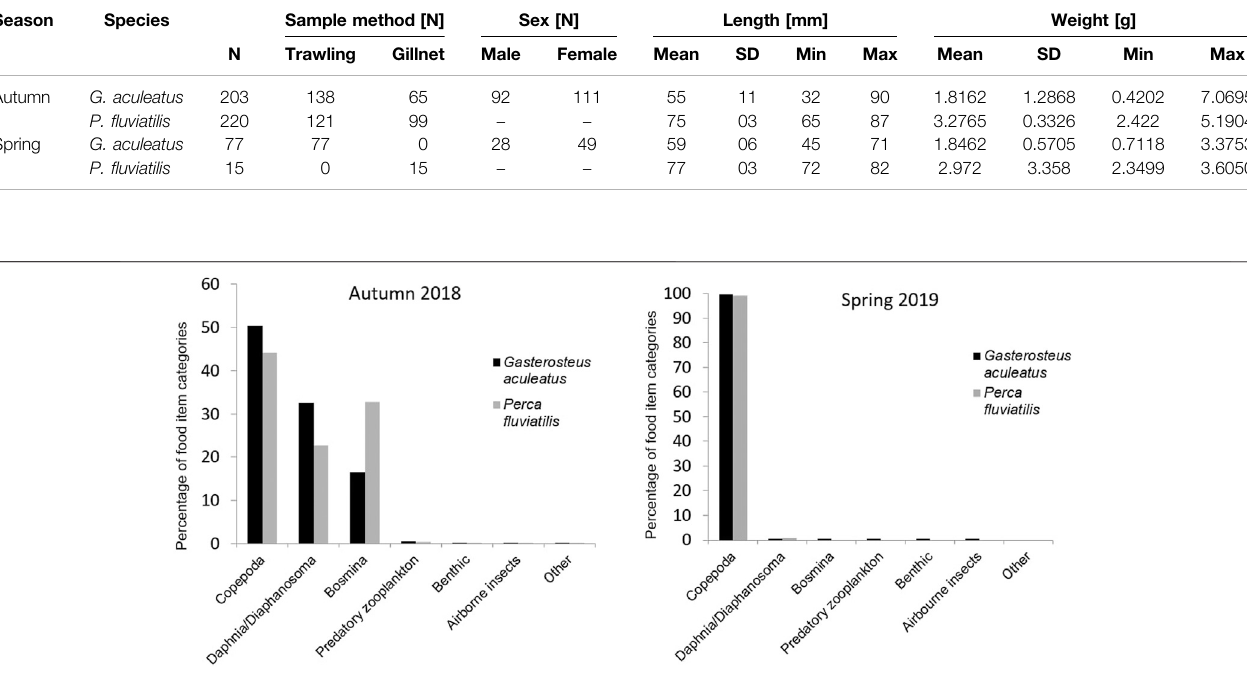
Frontiers in Environmental Science |